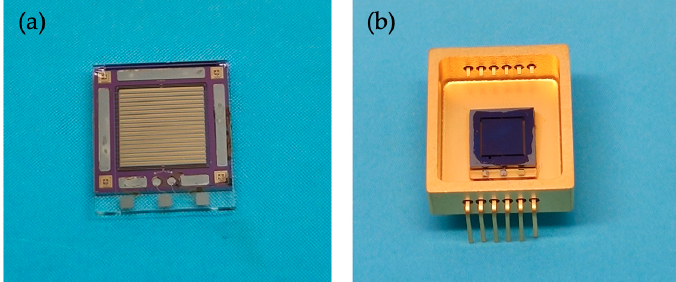
Figure 8. Diagrams of the accelerometer bare die and wire-bonding with the chip carrier: ( a ) the bare die of the MEMS accelerometer; ( b ) the customized chip carrier.